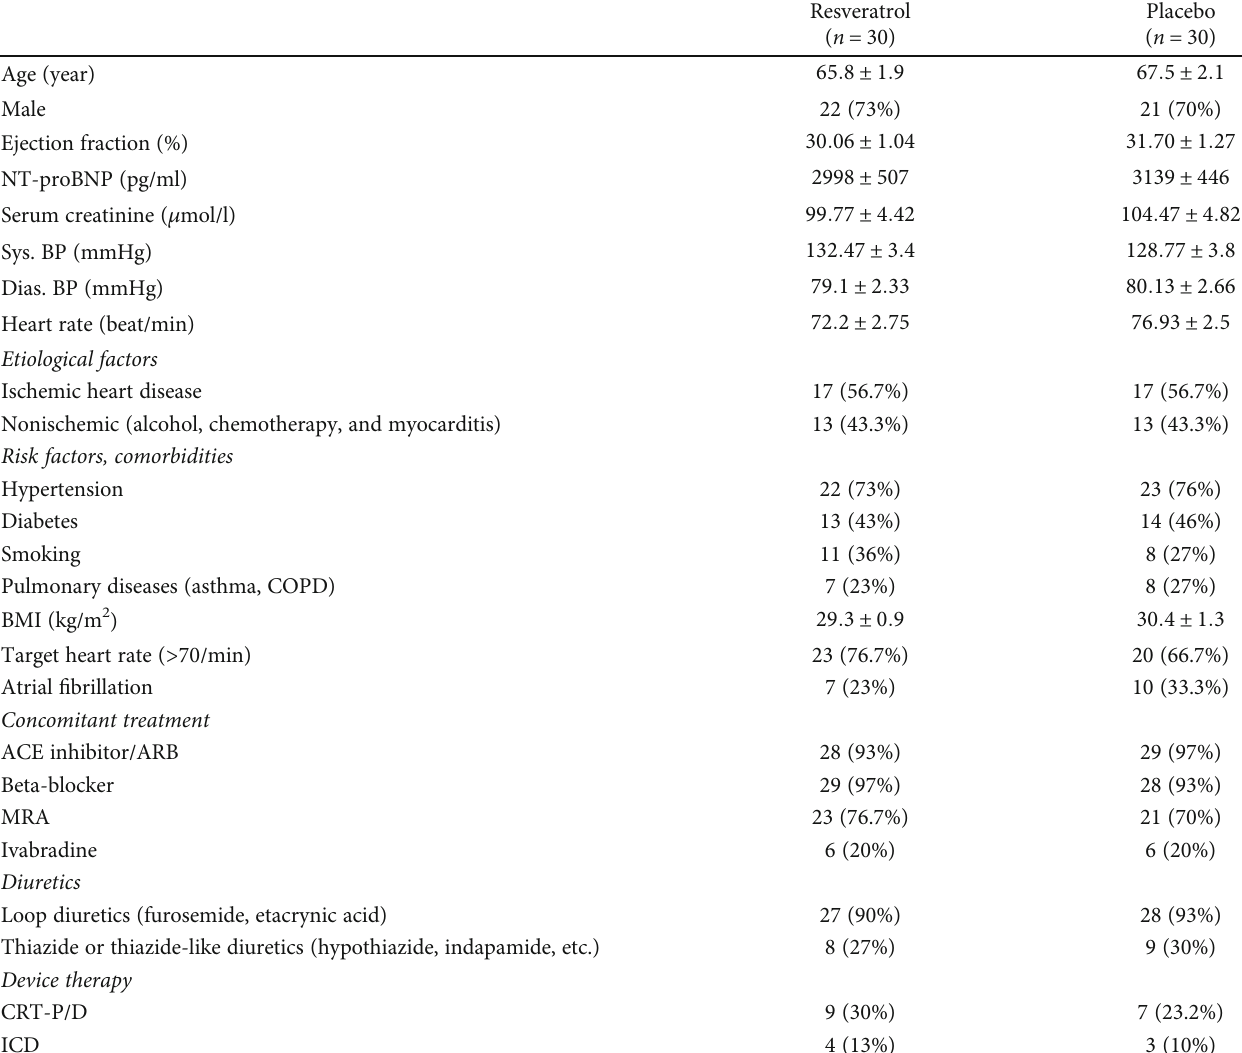
Table 1: Baseline characteristics of the study population according to the treatment